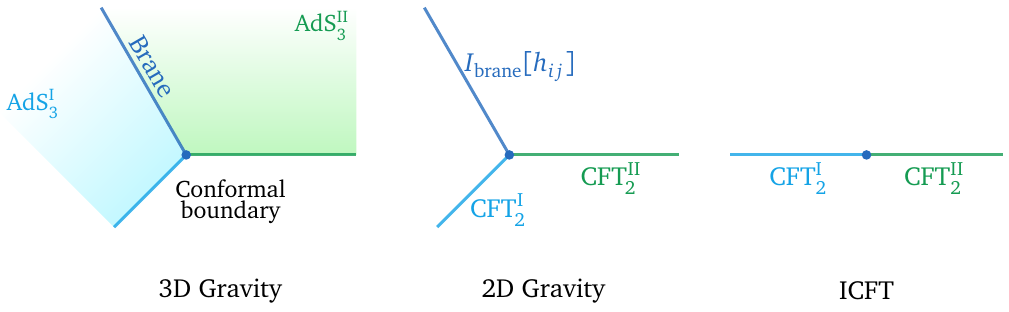
Figure 1: Three different perspectives on the same double holographic system.